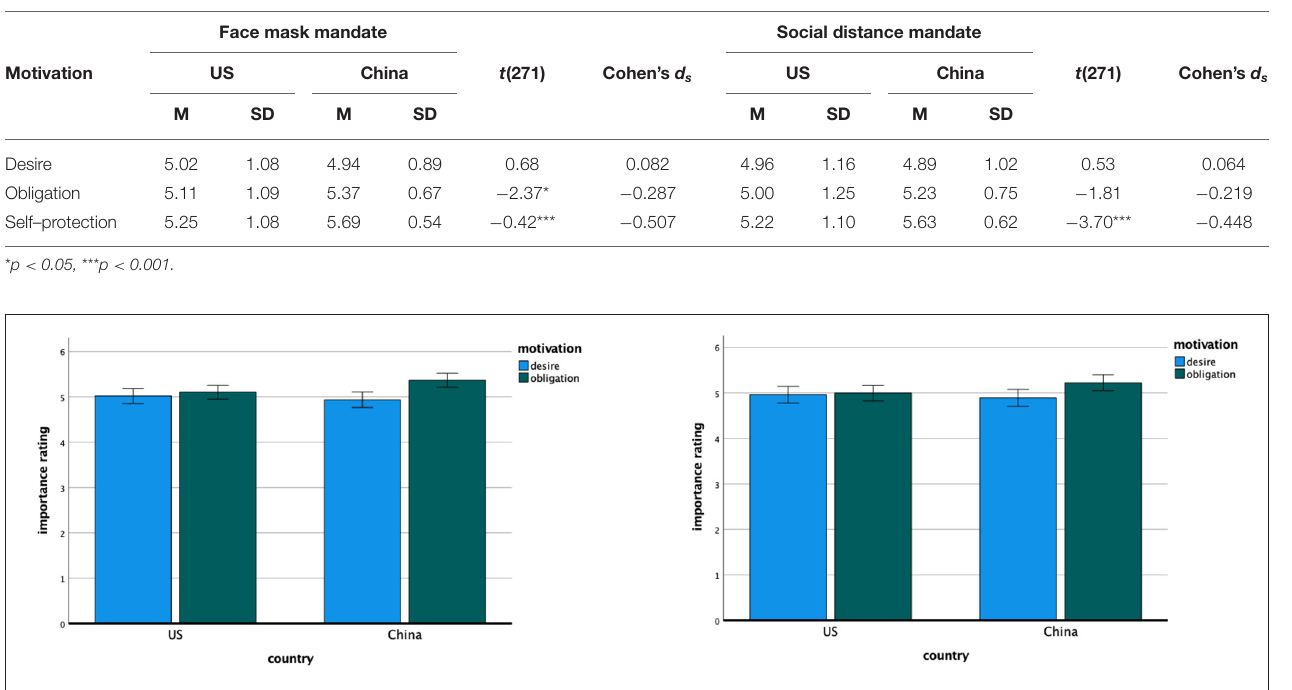
FIGURE 4 | Study 2—the importance ratings of desire and obligation motivation for wearing face masks (left) and keeping social distance (right) for American and Chinese participants. Error bars denote 95% confidence intervals of the mean.